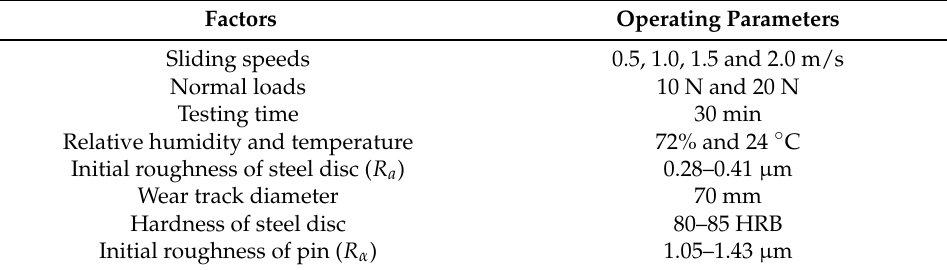
Table 2. Experimental parameters for pin-on-disc